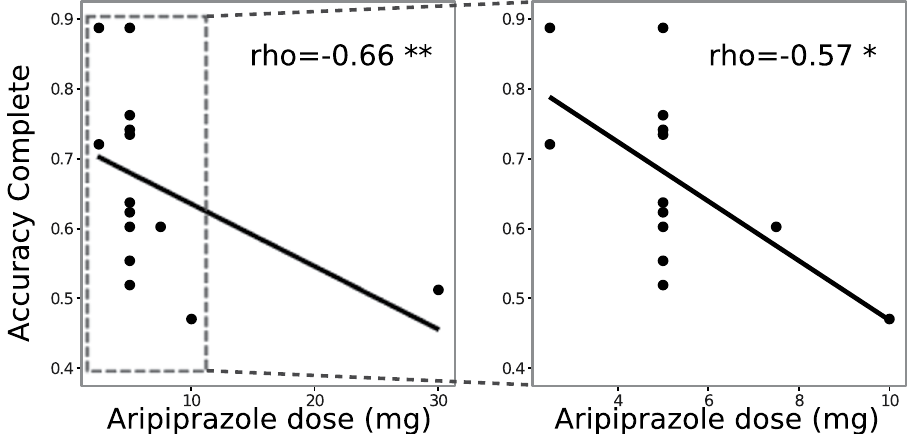
Figure 3. Correlation between aripiprazole dose and accuracy in the complete feedback context in all subjects (left) and excluding the subject with the highest dose (right).